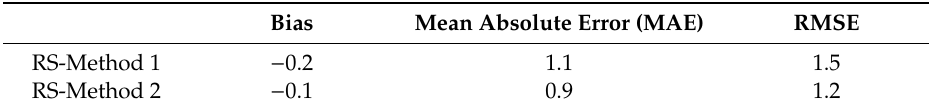
Figure 10. WV profiles comparisons derived from different tomography methods and RS at UTC 00:00 DOY 148, 2019 ( a ), and UTC 12:00 DOY 132, 2019 ( b ). Additionally, the RMSE of both tomography methods was least in epoch ( a ) but most in epoch ( b ). Table 3. Statistical comparison of RS-Methods 1 and 2 in the experimental period (g/m 3 ).